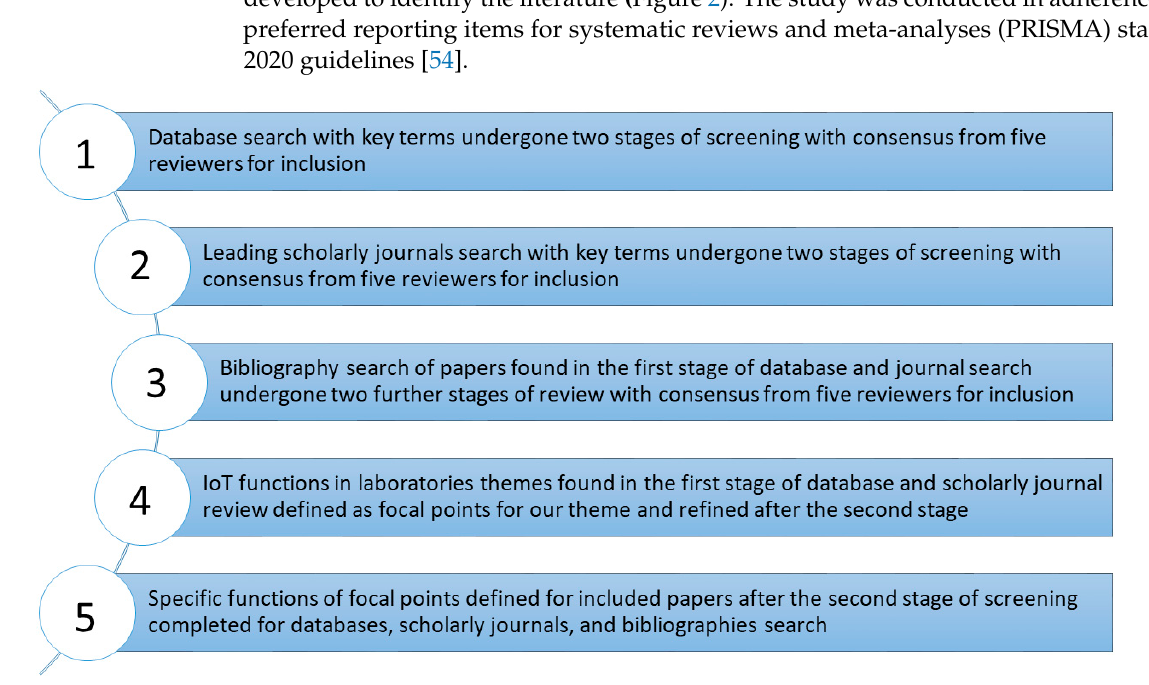
Figure 2. The concept-driven theoretical framework for the search strategy and selection of relevant investigations.